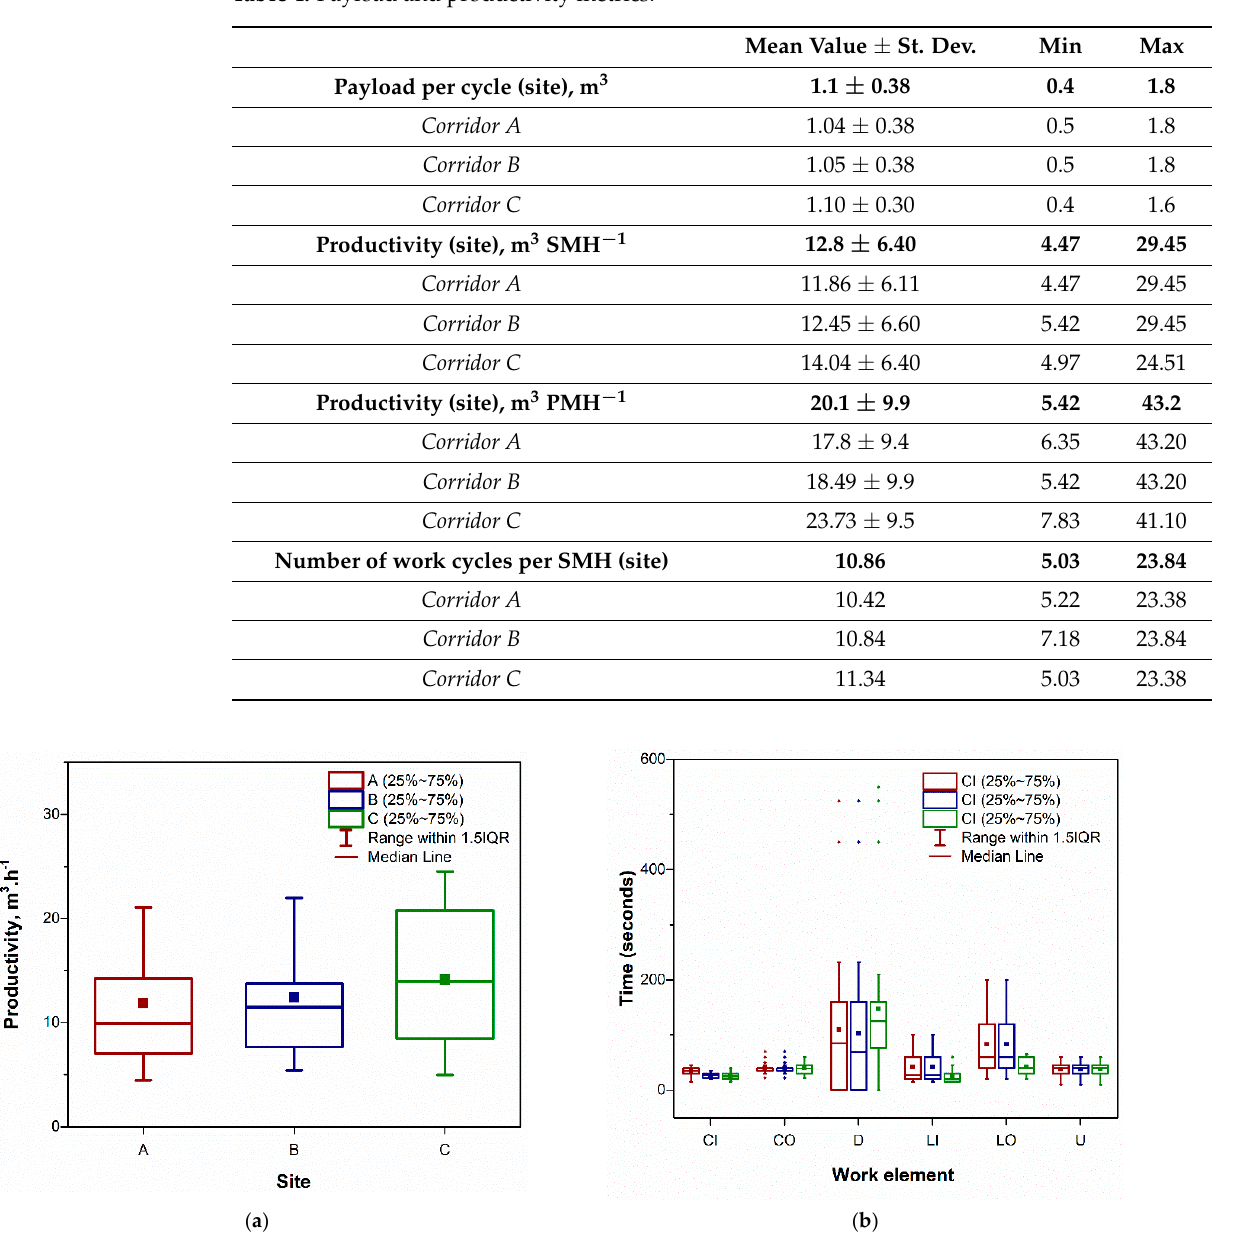
Table 4. Payload and productivity metrics.